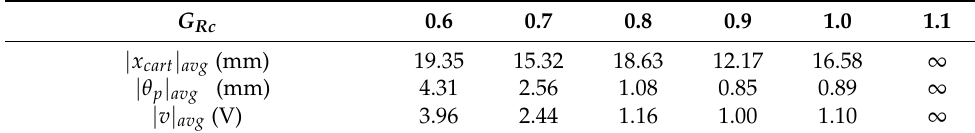
Table 2. Mean absolute values of cart displacement and control voltage with inner-loop LQR c only.